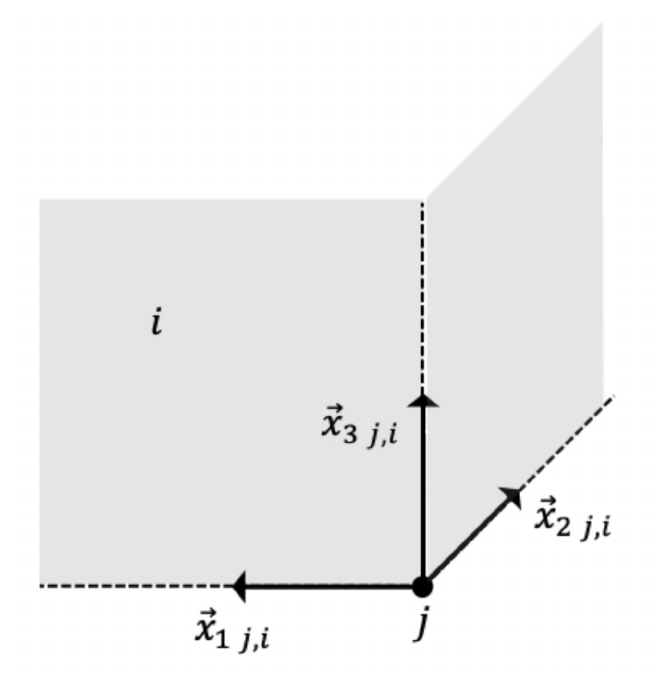
Figure 6. Vectors from the node j on element i to its adjacent neighbor